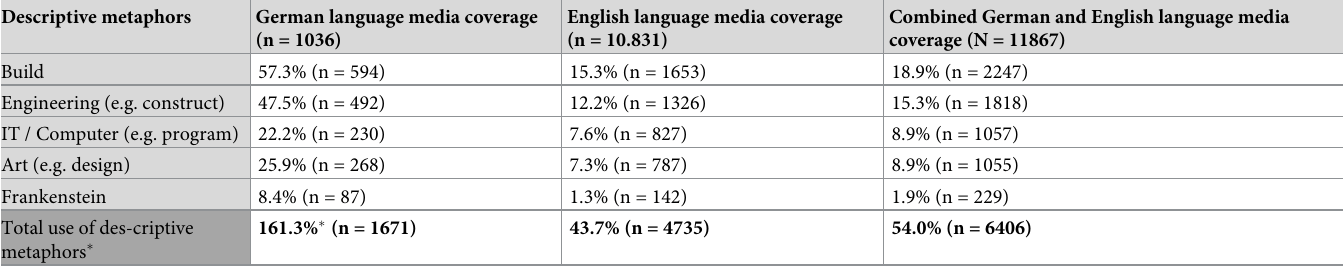
Table 2. Frequencies of most-used descriptive metaphors in German language and English language media coverage 2004–2015 (in percent). Descriptive